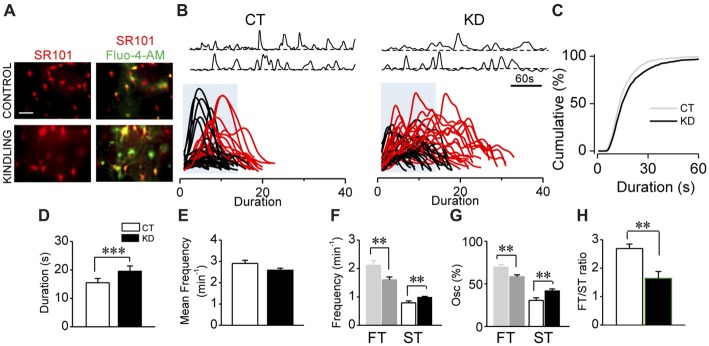
Kindled hippocampal slices display spontaneous astroglial Ca2+-mediated hyperexcitability. (A) Representative fluorescence microscopy images of SR101+ astrocytes (red; left) and maximum intensity projection obtained from 5 min video of fluorescence transients for Fluo-4-AM- loaded astrocytes of CA1 area (stratum radiatum) showed colocalization (yellow; right) both in control and kindled hippocampal slices (calibration bar 30 μm). (B) Representative Ca2+-fluorescence traces of spontaneous Ca2+ elevations in two astrocytes (top). Superimposition of spontaneous Ca2+ elevations obtained from several astrocytes (>10 cells), aligned at the start of each single transient. Some slow Ca2+ transients (>50 oscillations) were highlighted in red; blue boxes show the temporal window within 17 s (fast transients [FTs]; slow transients [STs] surpasses the blue box), detected in control (left, CT) and kindled (right, KD) slices. (C) Cumulative distribution plot of the spontaneous Ca2+ events duration obtained from all astrocytes analyzed for CT (n = 41; left) and KD hippocampi (n = 76; middle). Summary graphs of astroglial Ca2+ oscillations mean duration (D), mean frequency (E), ST and FT frequency (F), ST and FT oscillation percentage (G) and FT/ST ratio (H) for control and kindled groups. Statistics: Shapiro-Wilk test was employed for the distribution analysis of Ca2+ signals. Mann-Whitney-test and T-test were used for single comparisons and ANOVA with Bonferroni post hoc test for multiple comparisons (*p < 0.05; **p < 0.01; ***p < 0.001).